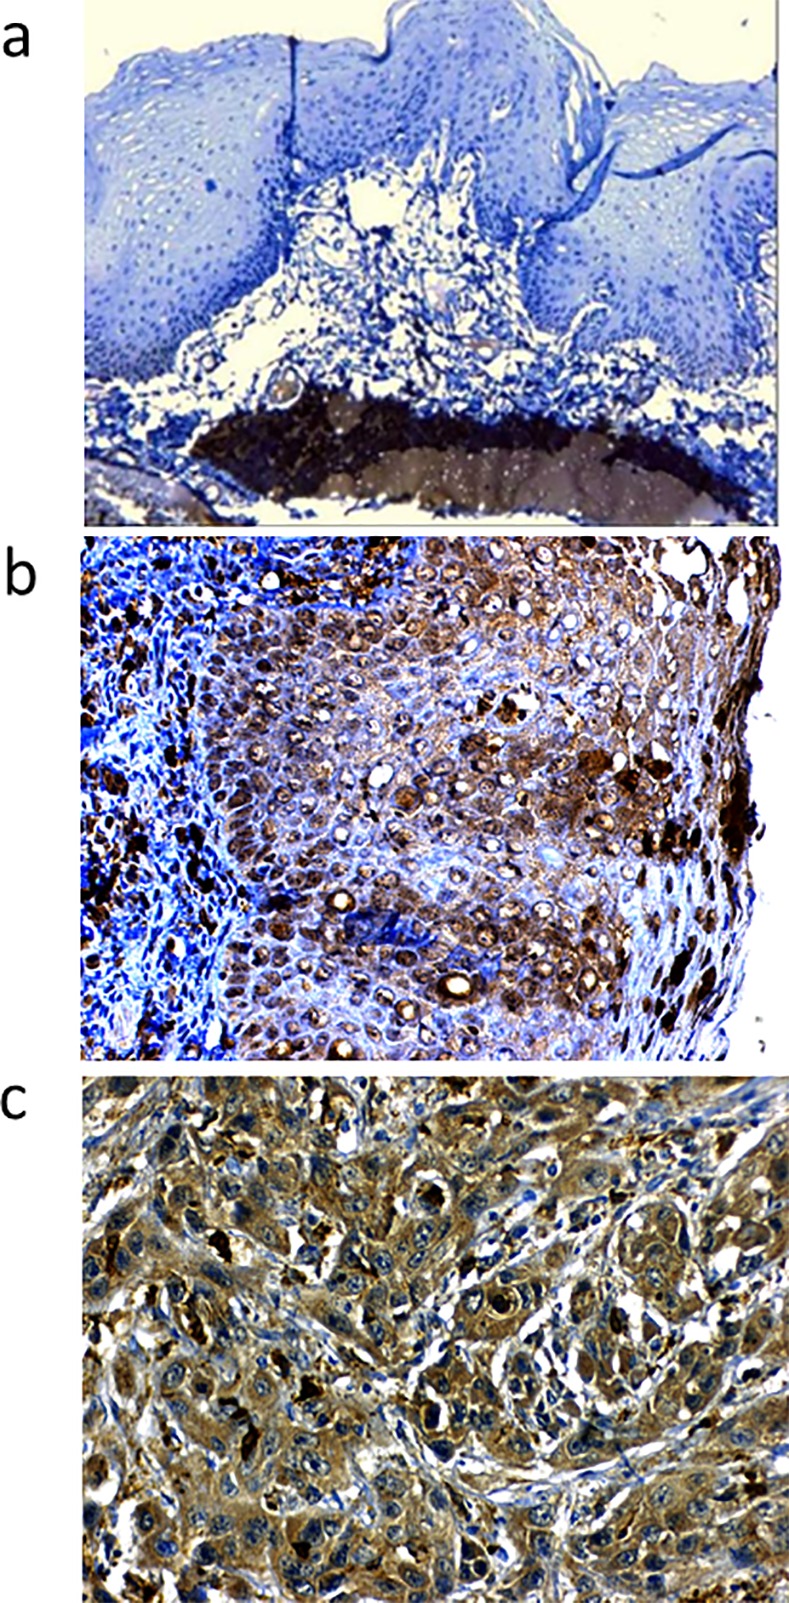
MMP9 expression by IHC (A) Normal tongue epithelium with no MMP9 expression (10X) (B) Intense MMP9 staining in areas showing severe dysplasia (40X) (C) Moderately differentiated SCC showing intense and diffuse MMP9 stain. (40X).